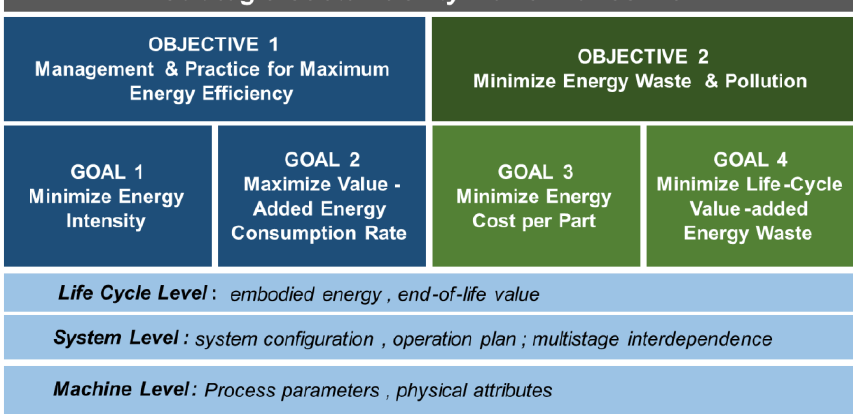
Figure 2. Overall strategic sustainability performance plan.